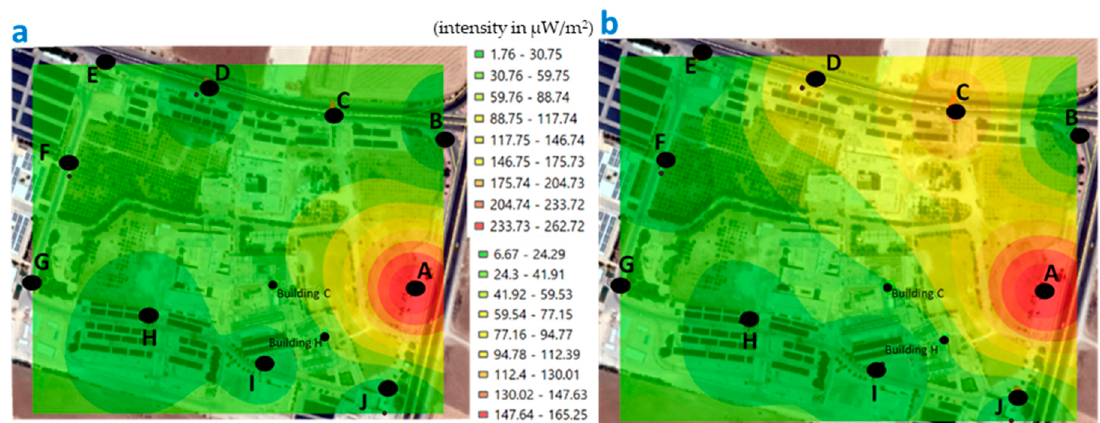
Figure 11. Georeferenced map with the levels of exposure recorded around the university area of the GJU, in the morning (points A-J). ( a ) weekend and ( b ) during the week ( μ W/m 2 ).